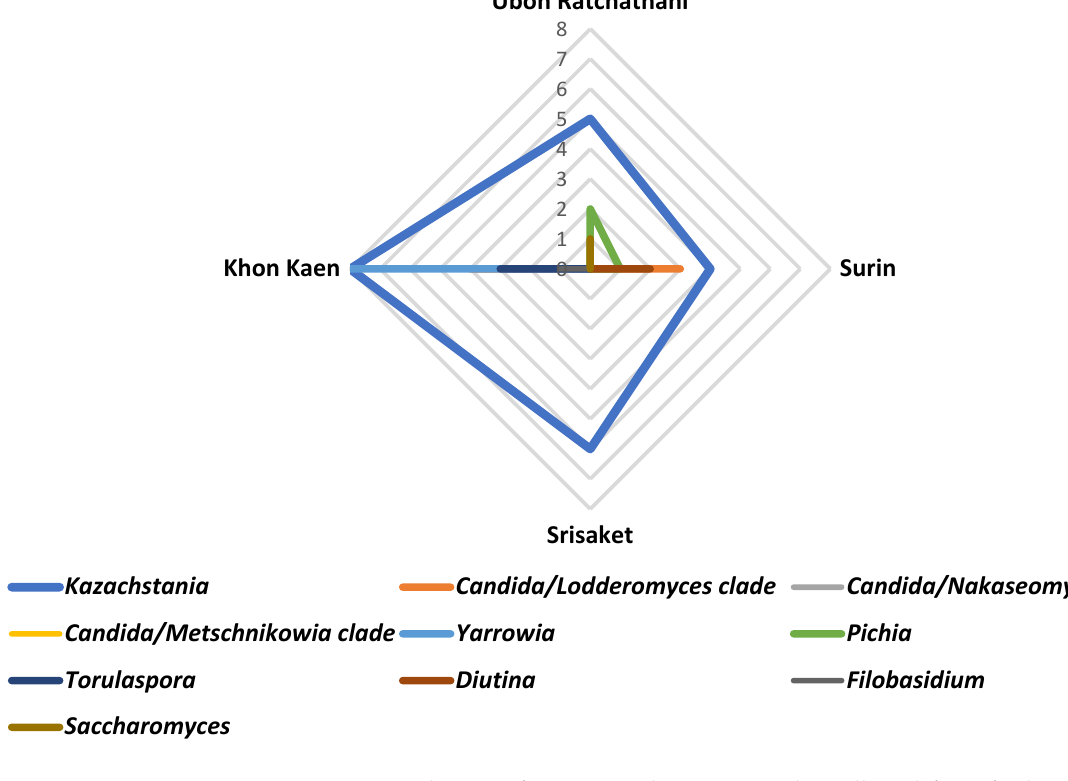
Figure 7. Distribution of yeasts in Plaa-som samples collected from fresh markets located in 4 prov- inces of Thailand.